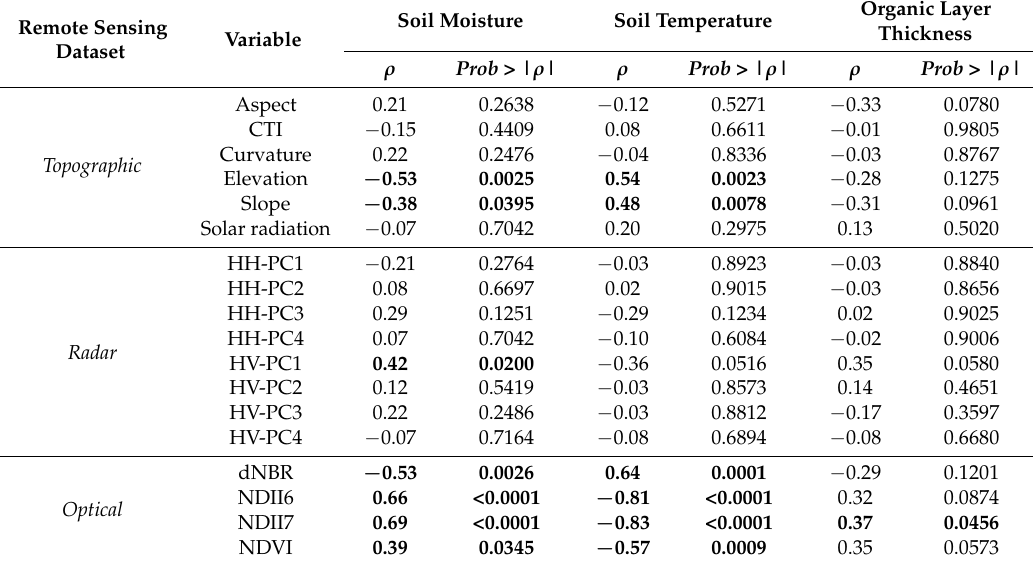
Table 5. Spearman’s rank correlations ( ρ ) between remote sensing metrics, volumetric soil moisture (upper 20 cm), soil temperature (1 m), and surface organic layer thickness. Significant relationships are highlighted in bold ( n =